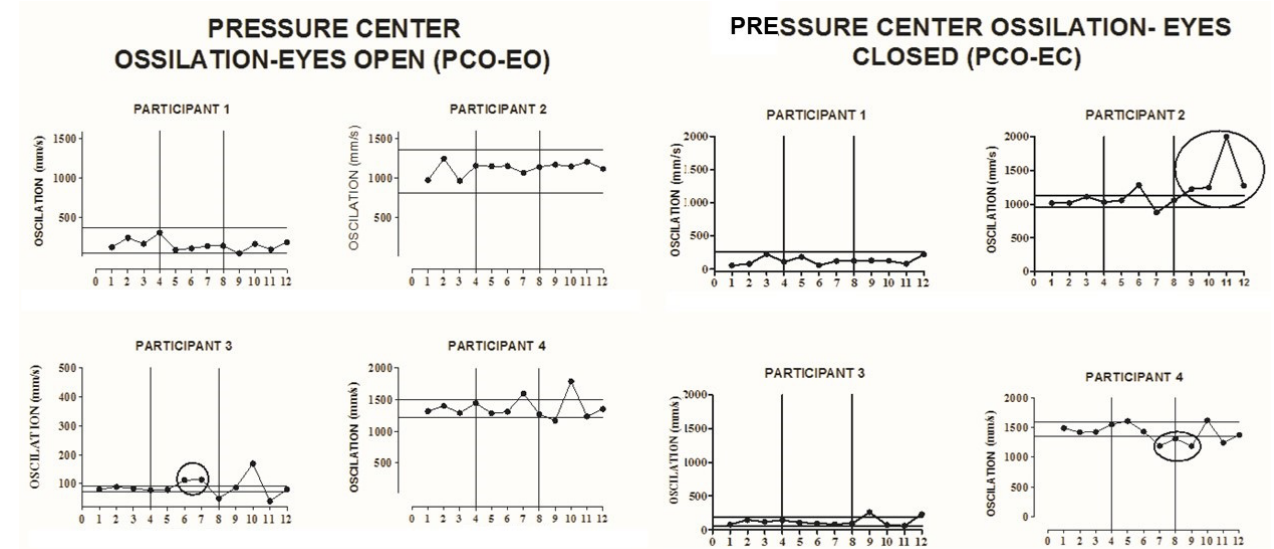
Figure 5. Visual representation of the Pressure Center Oscillation (PCO) with the Eyes Open (EO) and with the Eyes Closed (EC) at baseline, intervention, and follow-up phases for participants 1, 2, 3, and 4 ( P1 – P4 ). The solid horizontal lines indicate ± 2 standard deviations from the mean of the baseline data. The x-axis represents the phases A–B-follow up, and the vertical lines divide the phases. The circles that encompass data showed a change trend after a graphic visual inspection of the baseline.